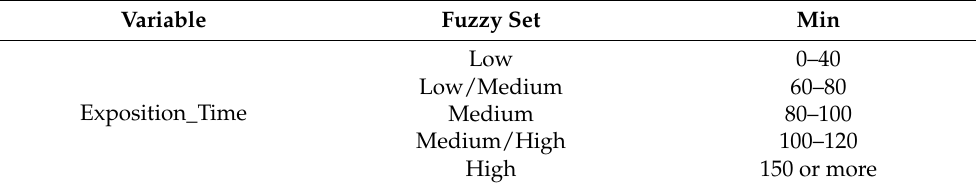
Figure 4. Membership function plots of Exposition_Time. Table 5. Ranges of time of exposition and their fuzzy